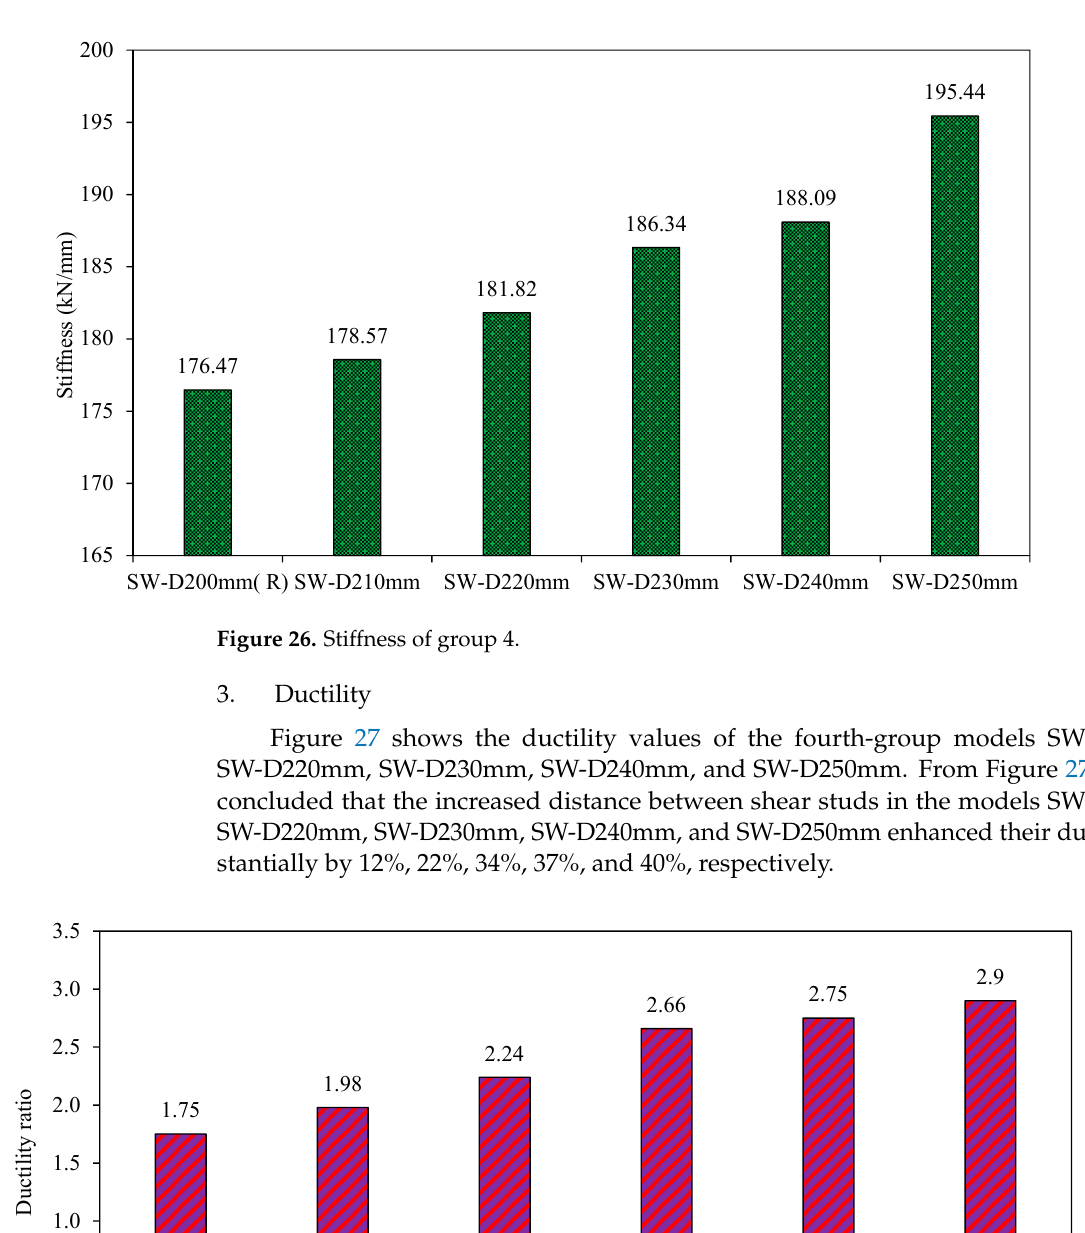
Figure 27. Ductility ratio of group 4.